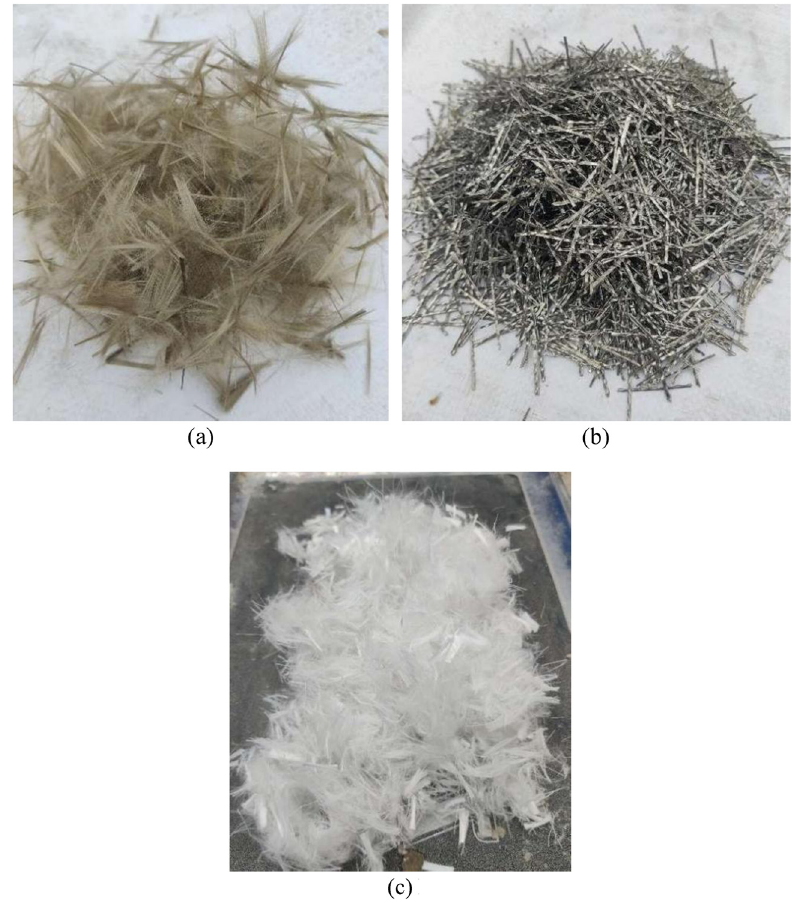
Figure 2: Fibers. ( a ) BF, ( b ) SF, and ( c ) PF.